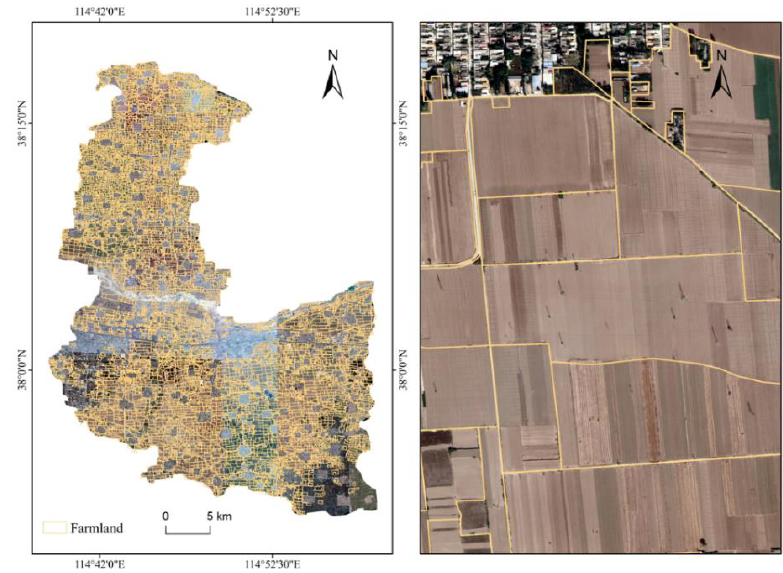
Figure 2. Farmland parcel data in the study area.